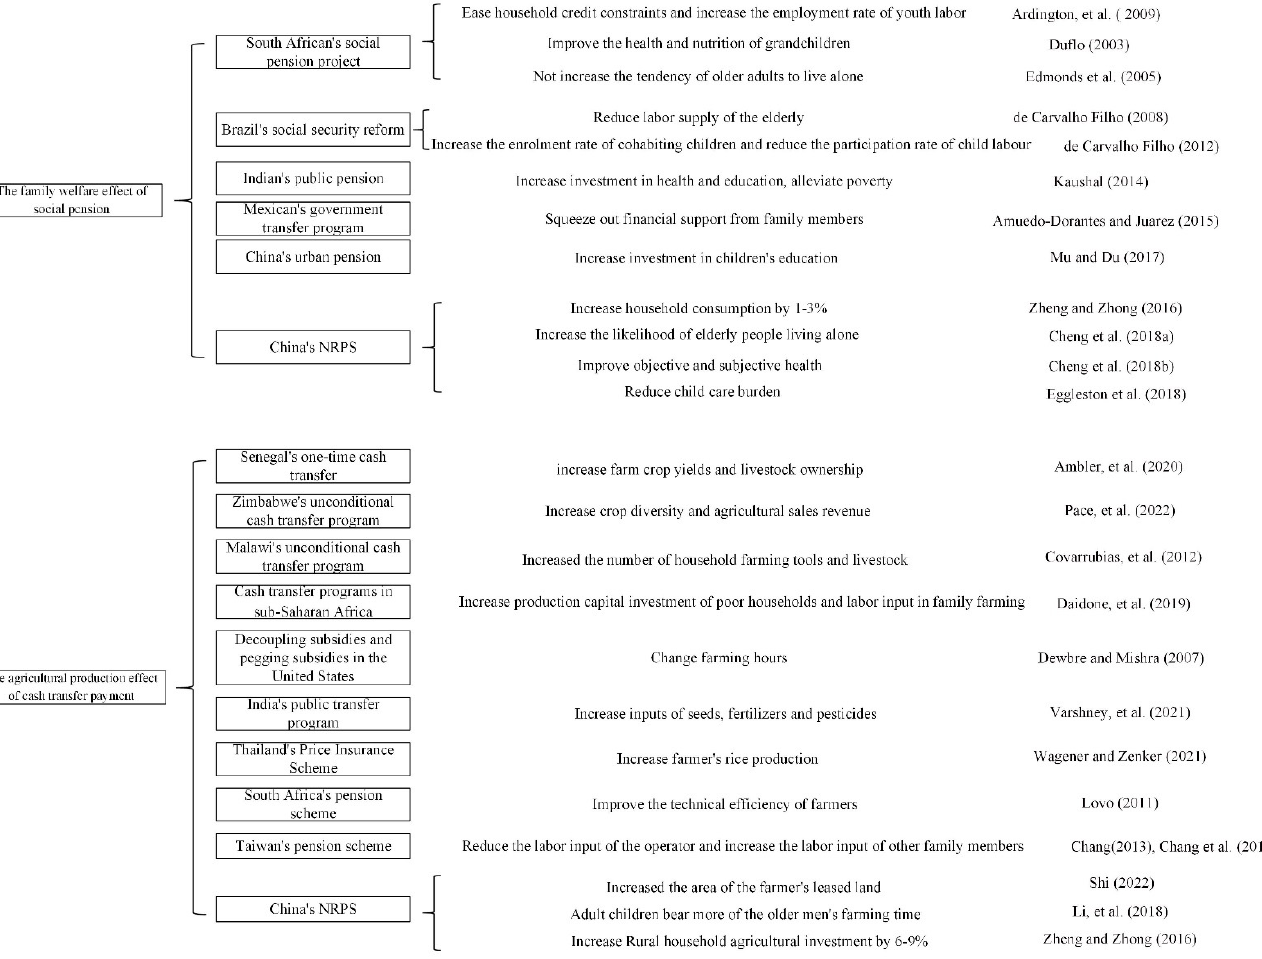
Figure 1. Flow diagram of literature review [1–4,6,12–29].